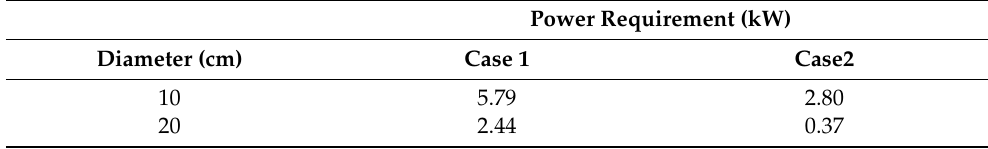
Table 7. Energy requirements for the pumping